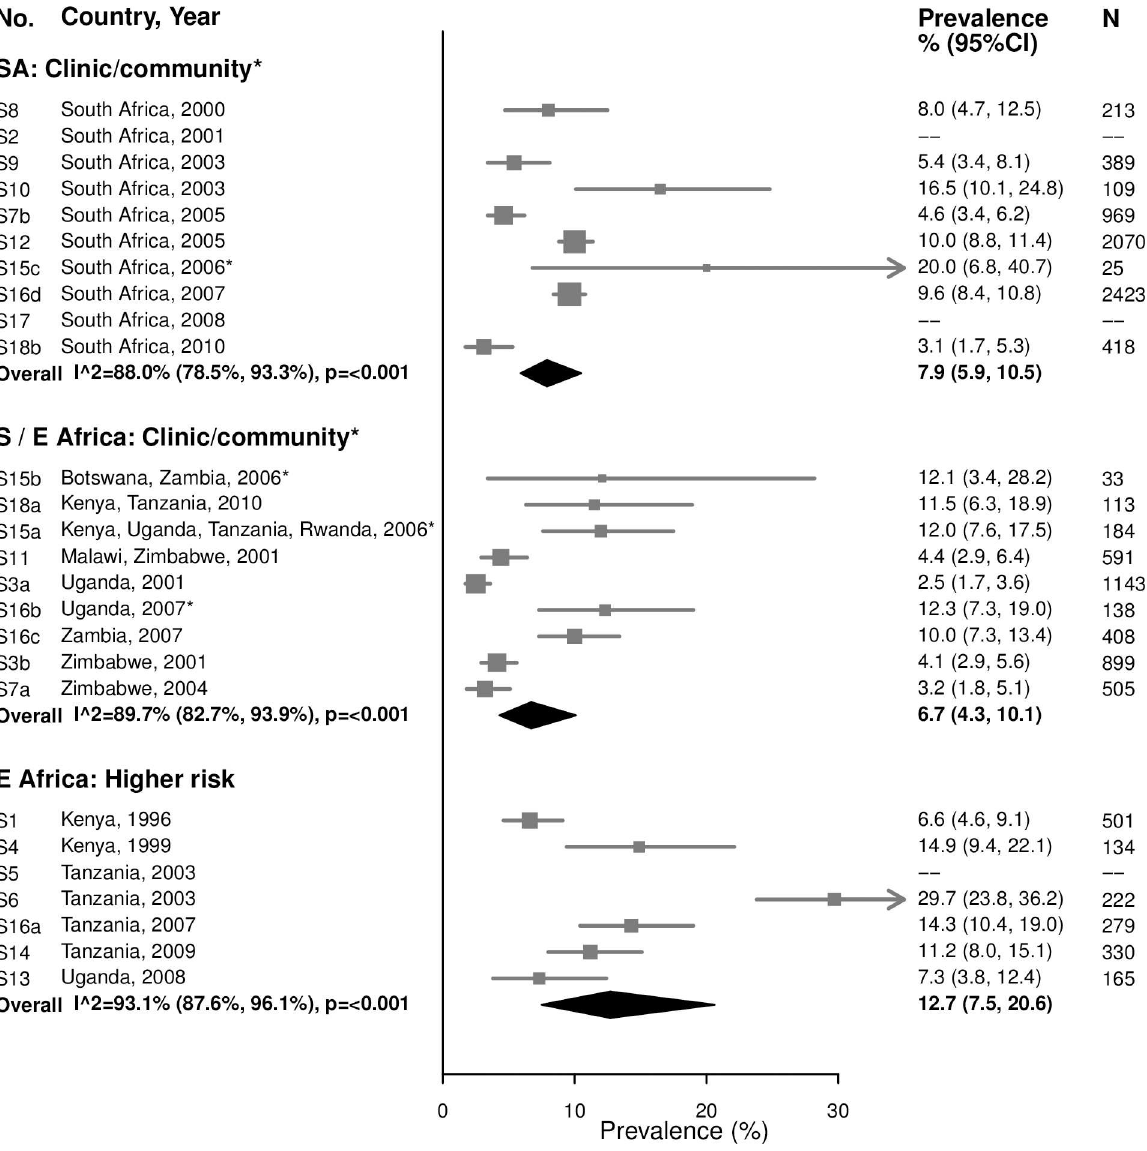
Fig 9. Trichomoniasis prevalence among 15–24-year-olds. The area of the marker is proportional to the square root of the sample size. Studies with no estimate presented did not meet the inclusion criteria for this infection and age group. Year presented is the median year that baseline data were collected during the study. (cid:3) Includes studies of HIV-discordant couples. E Africa, Eastern Africa; SA, South Africa; S/E Africa, Southern and Eastern